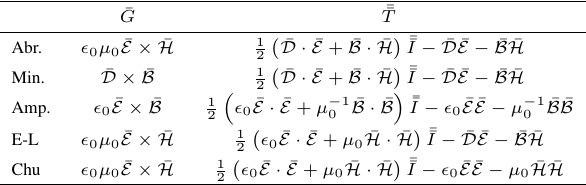
Table 1: Leading electromagnetic momentum densities and stress tensors.